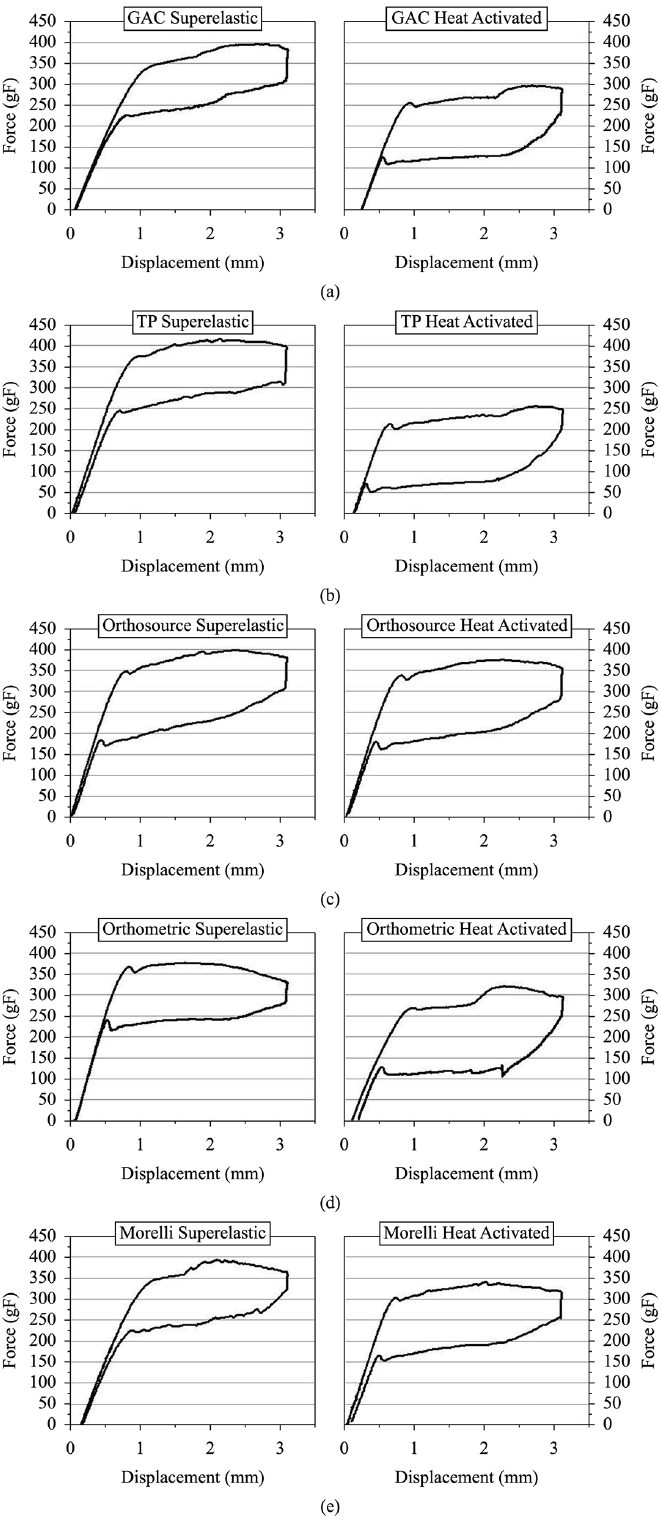
Figure 4. Load/deflection curves of 0.014’ NiTi Superelastic and Heat-Activated archwires until 3.1 mm deflection at 37 °C. Manufacturers are: (a) GAC, (b) Tp, (c) Orthosource, (d) Orthometric, (e)